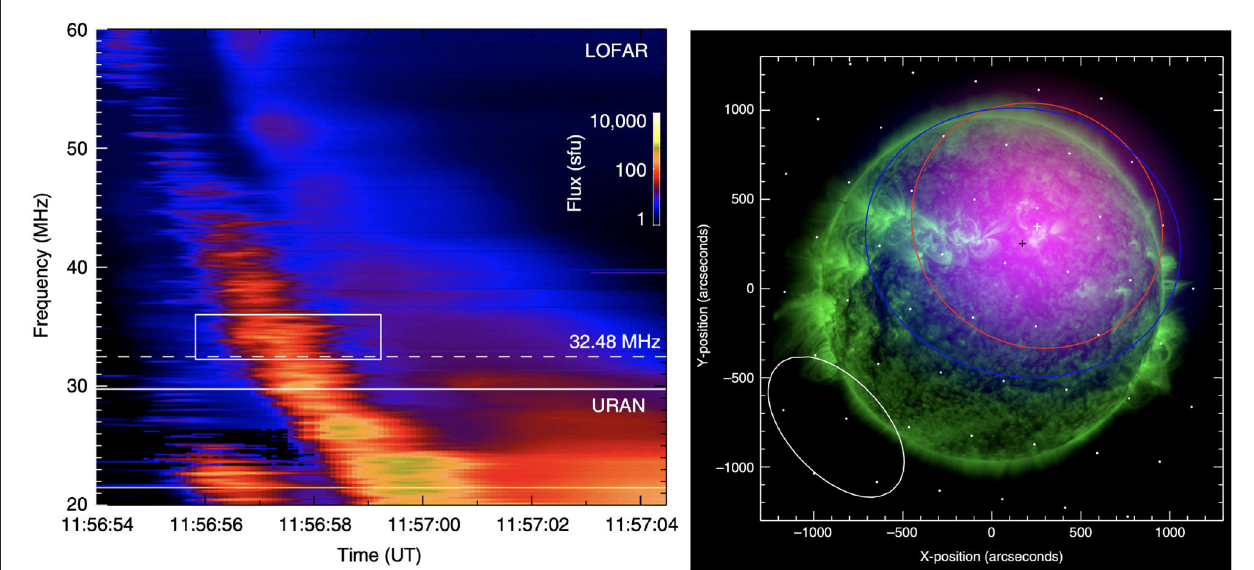
FIGURE 7 | Left: Type IIIb dynamic spectrum showing the fundamental and harmonic pair with significant fine structure observable in the fundamental emission. Right: Image of the fine structure component with fundamental in red and harmonic in blue. The background is the EUV Sun. Adapted from Kontar et al. (2017).